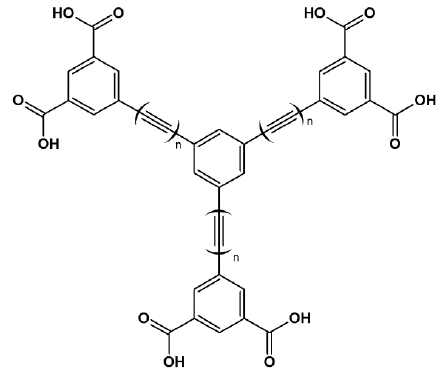
Figure 4. A 1,3,5-trisubstitued benzene with linear chains made of alternating single and triple bonds ending with a 3,5-dicarboxybenzene, a building block for MOF with ultra-high surface-areas